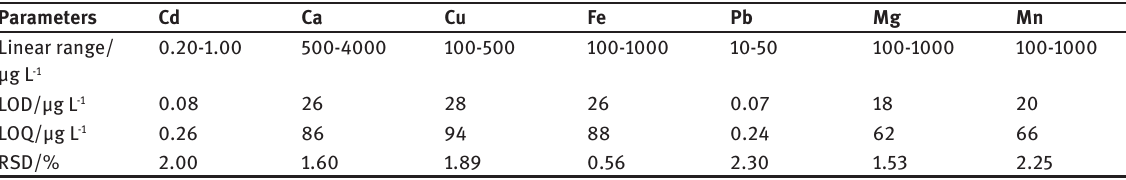
Table 2: Linear range, LOD, LOQ and RSD for Cd, Ca, Cu, Fe, Pb, Mg and Mn in FAAS analyses. Parameters